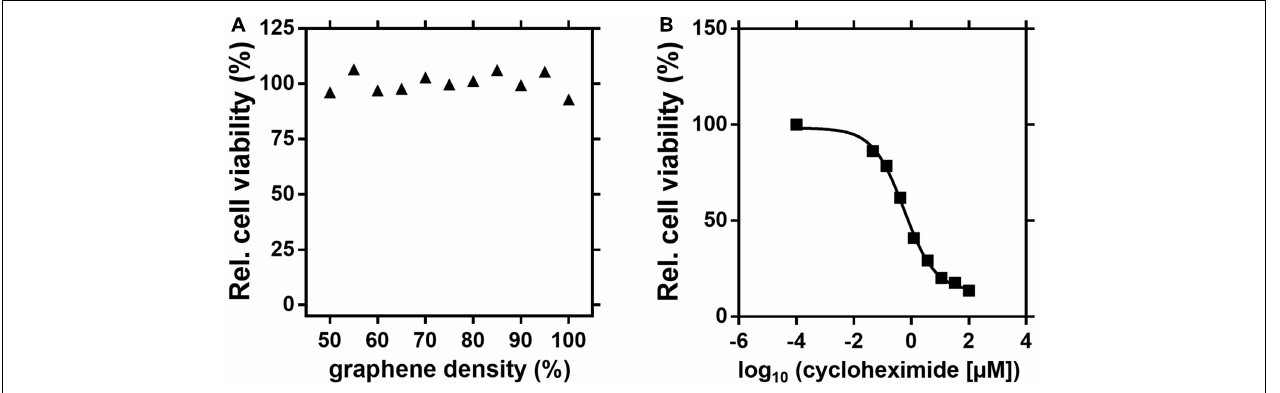
FIGURE 2 | No influence of the graphene ink on the cell viability of HuH-7 cells. About 1-cm 2 pieces of graphene ink-printed PET-foil in different densities, ranging from 50 to 100%, were preincubated for 24 h in a culture medium. Subsequently, a cell viability assay with the AlamarBlueTM reagent was performed with these conditioned media. An effect of graphene-conditioned media on cell viability of HuH-7 cells was not observed (A) . In a control experiment with fresh media and different concentrations of cycloheximide, the cytotoxic agent showed a dose-dependent effect on the viability of HuH-7 cells with a calculated CC50 value of approximately 0.6 µ M (B) .